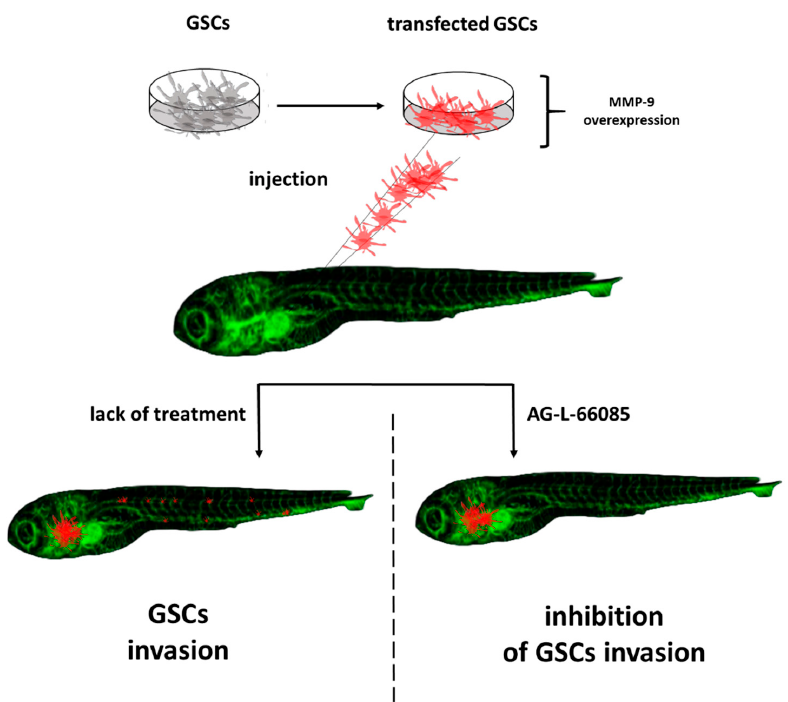
Figure 2. Participation glioma stem cells ( GSCs) in the invasion using the zebrafish model. MMP-9-matrix metalloproteinase; AG-L-66085-MMP-9 inhibitor (based on results shown by Yang X jun et al.) [41].